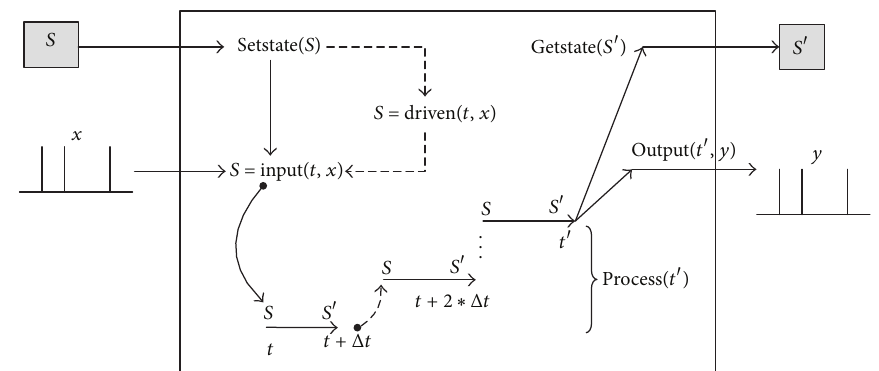
Figure 3: Execution flow of reusable component model.